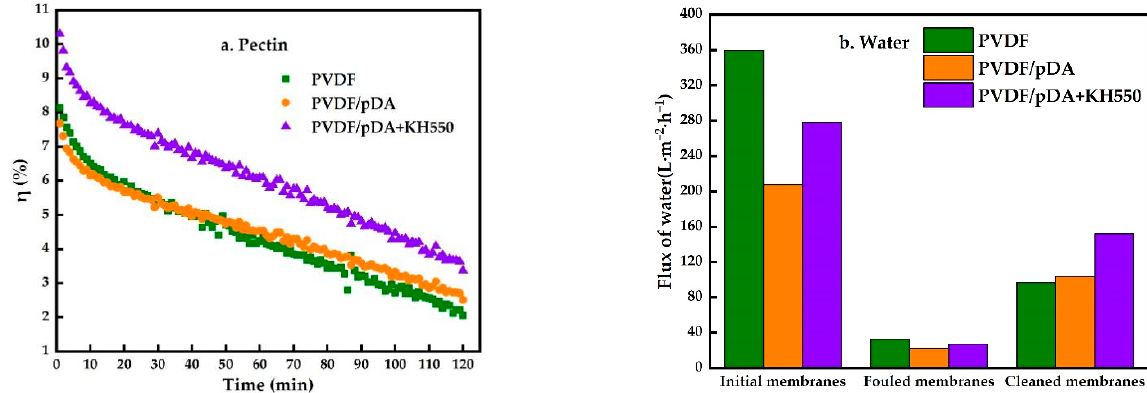
Figure 6. Relative flux of pectin solution ( a ), and flux of water at different stages ( b ).